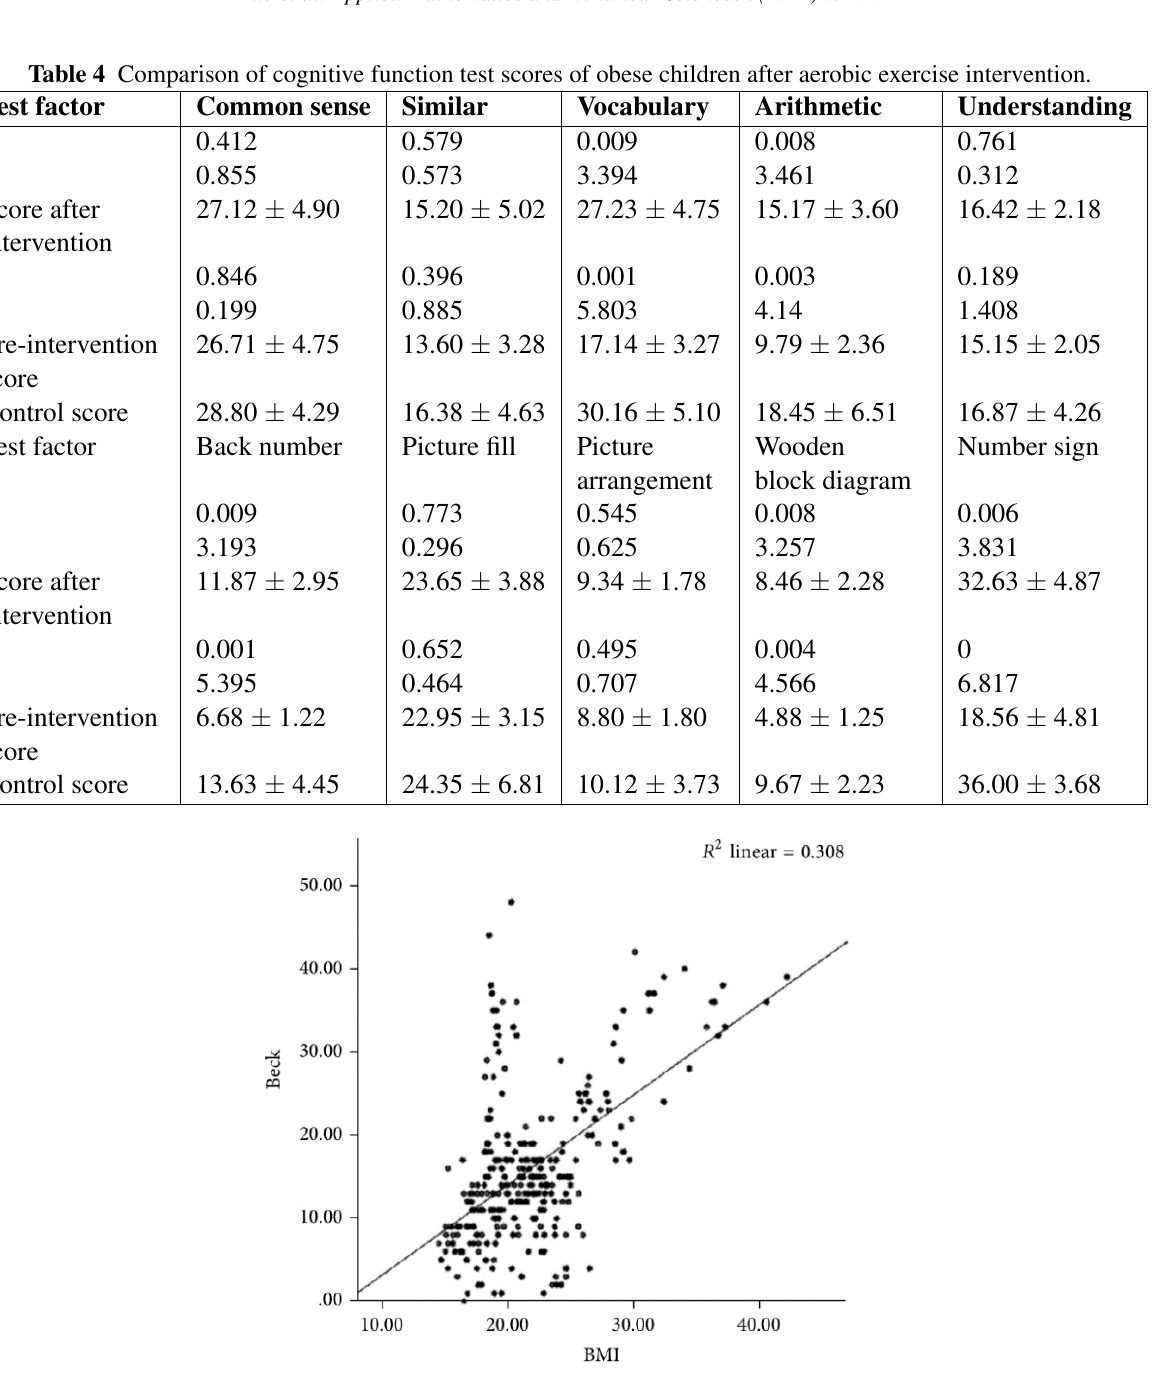
Fig. 1 The correlation between BMI and neuropsychological test scores in obese